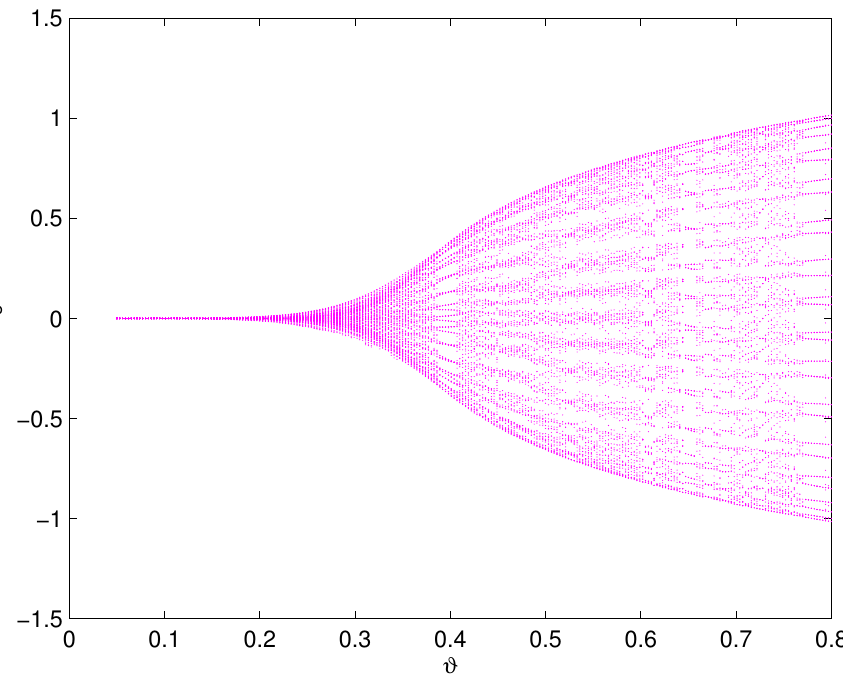
Figure 5. Bifurcation graph of system (71): the delay ϑ versus the variable w 3 . The bifurcation number is